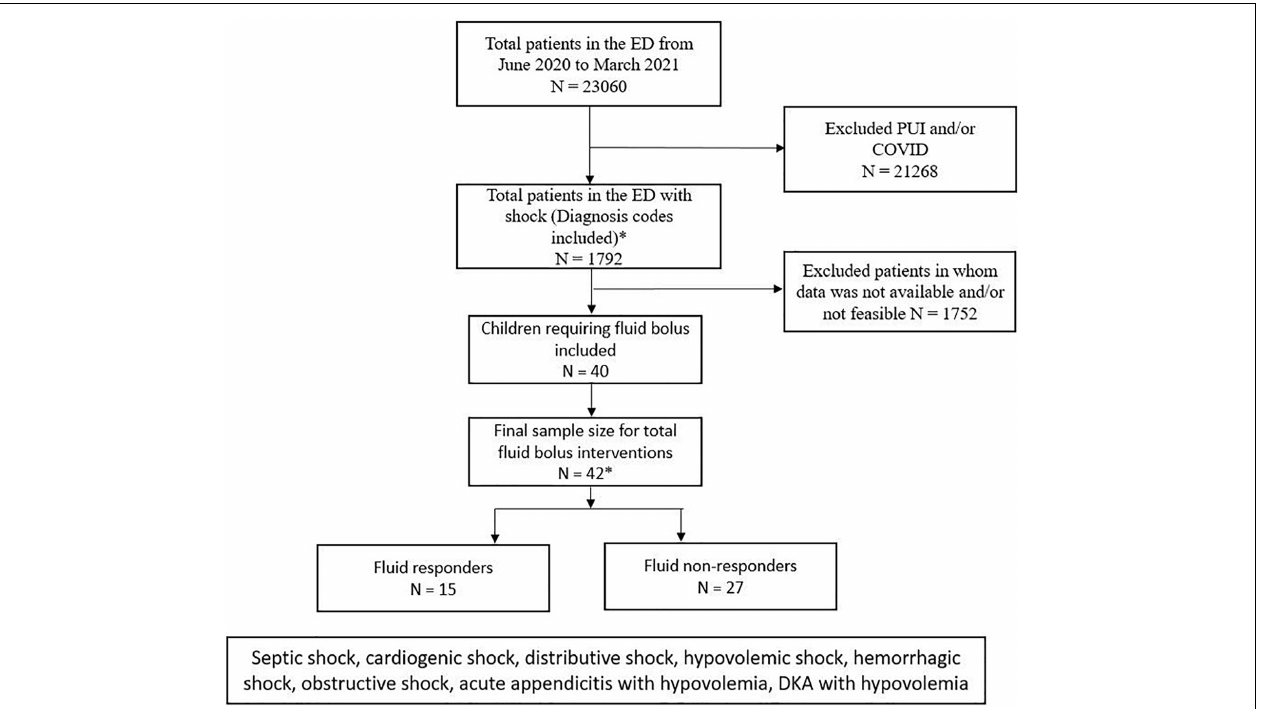
FIGURE 2 | Consort patient flow diagram showing the total number of ED visits in our study period and number of patients who were included and excluded in the study. PUI, patients under investigation, COVID, coronavirus disease.